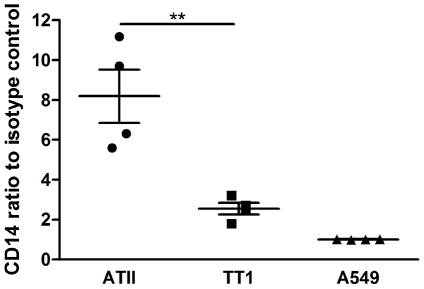
Comparative expression of CD14 on primary human ATII cells, immortalised TT1 cells and A549 cells.Cells were immunostained with CD14 and cells surface expression measured using flow cytometry. The ratio of median fluorescent intensity of CD14 staining relative to IgG control was calculated for all cells. Results demonstrated that both ATII cells and TT1 cells express CD14 whereas A549 cells do not. Furthermore, ATII cells had significantly higher CD14 staining than TT1 cells. Data expressed as mean ± SE (n = 4 subjects). **P<0.007.